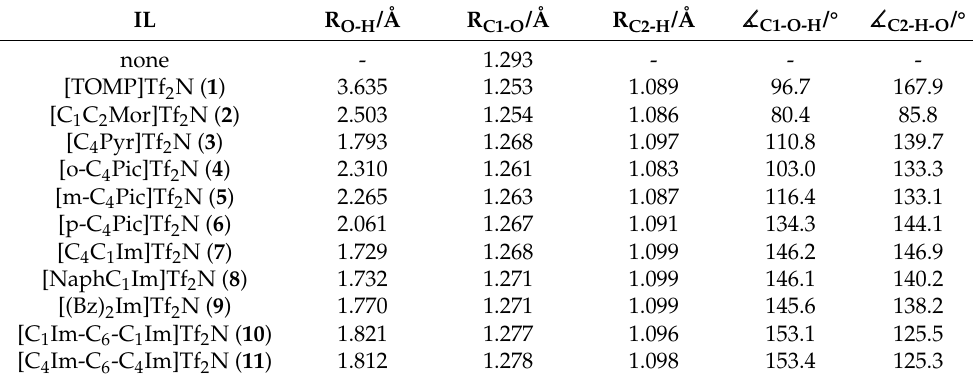
Table 1. Some geometric quantities related to cation-Reichardt’s dye 1:1 complexes.